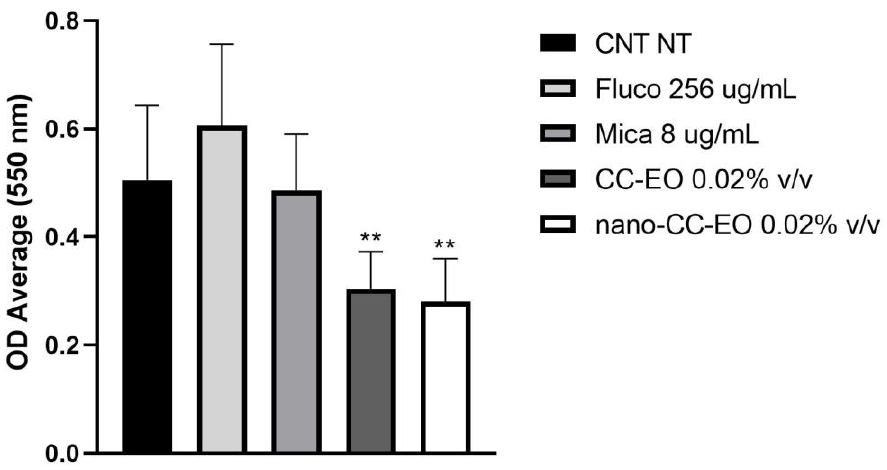
Figure 1. Eradication of performed biofilm. (**) indicate a statistical significance corresponding to p < 0.001 .